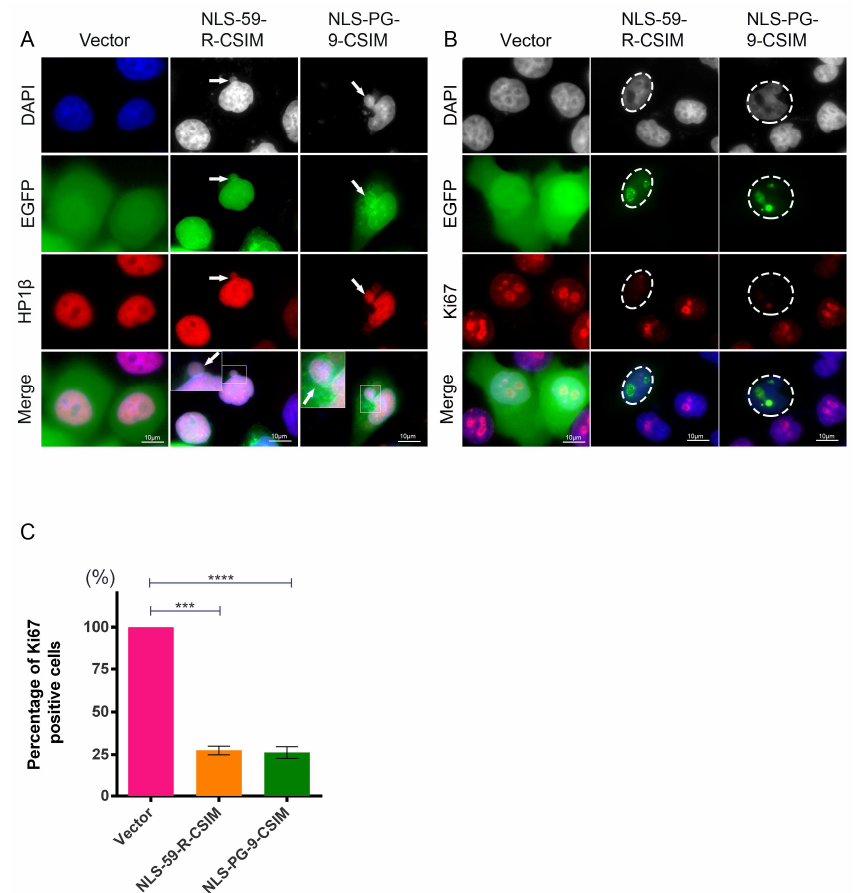
Figure 4. Determination of the heterochromatin organization and cell proliferation activity. ( A ) Heterochromatin was stained with an anti-HP1β antibody. Representative images of HP1β staining in EGFP vector-, EGFP–NLS-59-R-CSIM-, and EGFP–NLS-PG-9-CSIM-transfected cells. Cytoplasmic HP1β staining shows the disorganized heterochromatin signals in EGFP–NLS-59-R-CSIM- and EGFP–NLS-PG-9-CSIM-transfected cells, as indicated by the arrowheads. Higher magnification images show the colocalization of DAPI and heterochromatin staining in the cytoplasm. Scale bar, 10 μm. ( B ) Ki67 was used to detect the actively replicating chromosomal DNA. Representative images of Ki67 staining and signals for EGFP fusion proteins are shown. Ki67 signals are barely detectable in EGFP–NLS-59-R-CSIM- and NLS-PG-9-CSIM-expressing cells, as indicated with circles. ( C ) Percentages of cells expressing both EGFP and Ki67. Nine hundred sixty cells expressing the EGFP vector, 919 cells expressing EGFP–NLS-59-R-CSIM, and 934 cells expressing EGFP–NLS-PG-9-CSIM were counted ( n = 3). Scale bar, 10 μm.